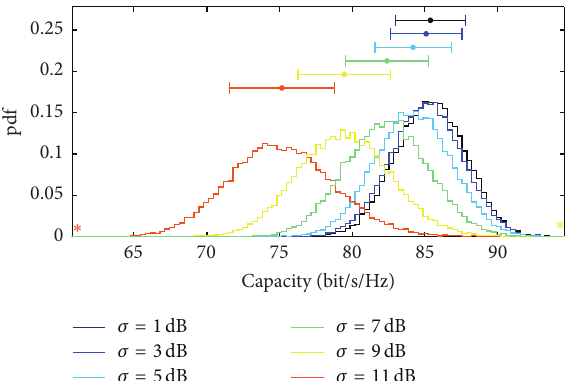
(Figure 10(b)) 𝜎 = 7 dB (Figure 10(c)), and 𝜎 = 10